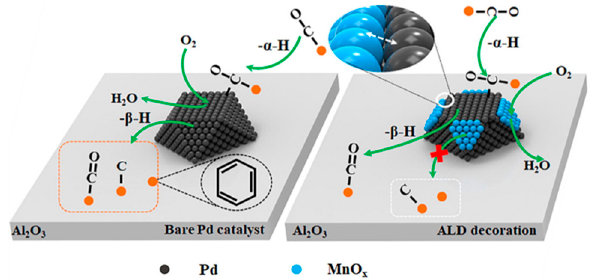
Figure 21. Schematic representation of the structure-property mechanism of (MnO x / )Pd / Al 2 O 3 for benzaldehyde oxidation. For unmodified Pd / Al 2 O 3 (left) benzyl alcohol is first adsorbed on Pd 0 , and a Pd atom is located between the O-H of the alcohol to form a metal alkoxide and a metal hydride (adsorbed on adjacent Pd atoms); then, a hydrogen atom is removed by the surface Pd atom through the β -H elimination process to form benzaldehyde; finally, the adsorbed hydrogen is oxidized by absorbed oxygen to regenerate the Pd active sites. For ALD MnO x -modified Pd / Al 2 O 3 (right) molecular oxygen is adsorbed on MnO x and activated to adsorb the H atom of the metal alkoxide formation process and the H atom of the β -H elimination process to form benzaldehyde and H 2 O. Selective Pd(111) facet passivation eliminates the formation of toluene via decarbonylation of benzaldehyde. Concomitantly, benzene formation over these facets is decreased. Reprinted with permission from Ref. [323].